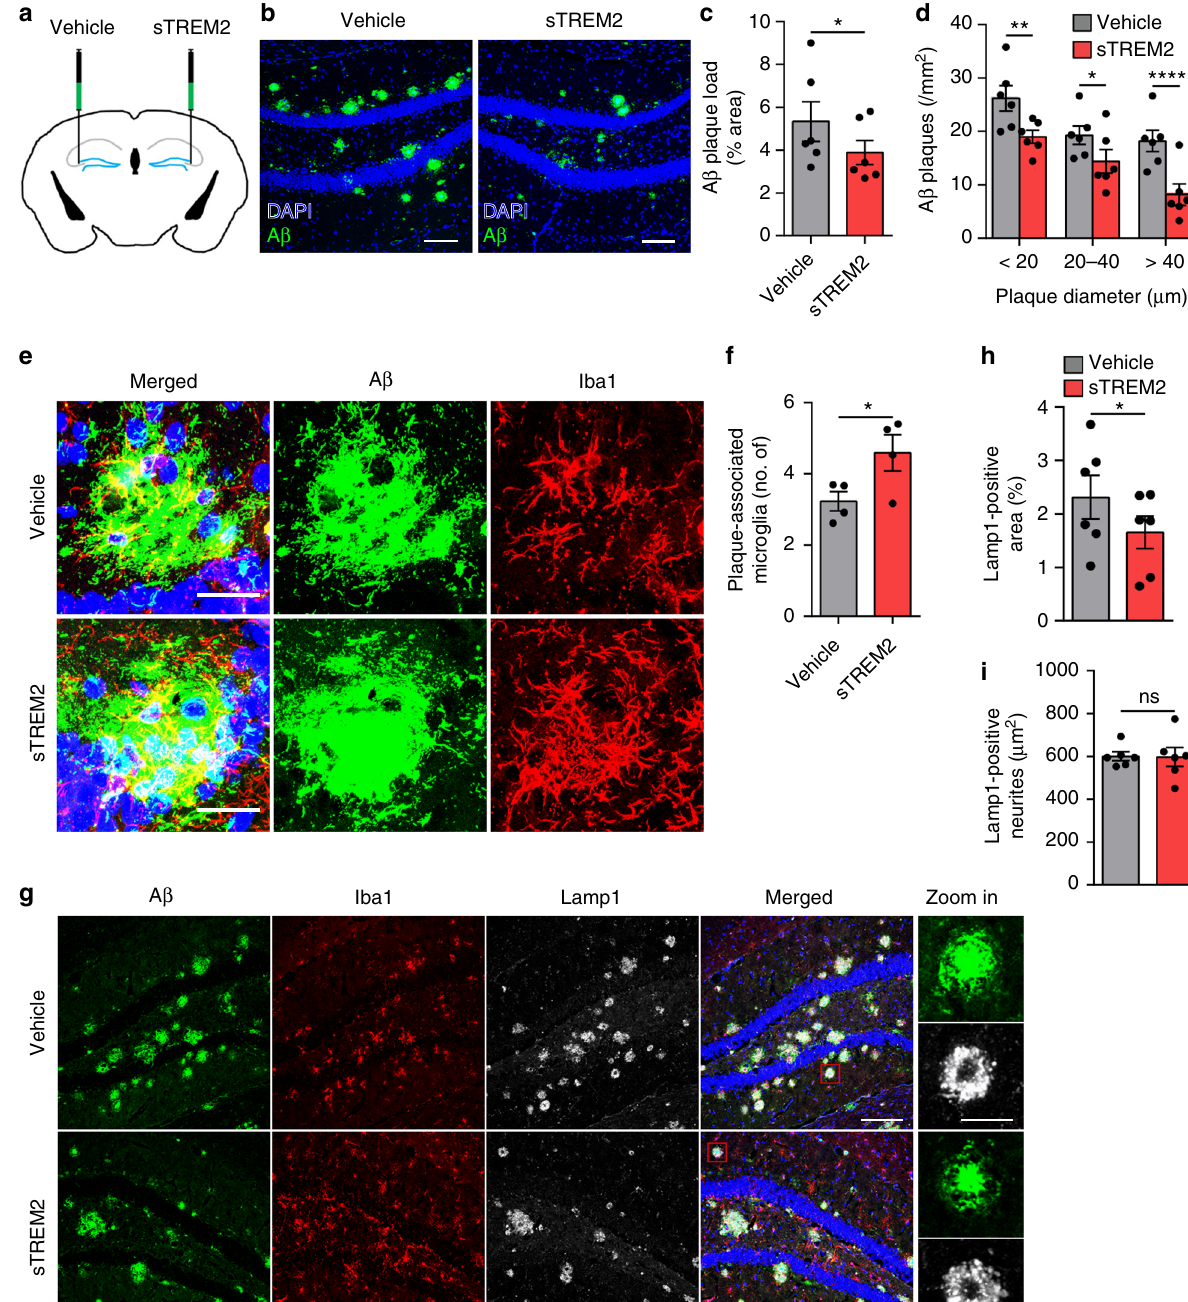
Fig. 2a), consistent with our previous report that sTREM2 promotes microglial activation 43 . Importantly, both the pro-in fl ammatory cytokine IL-1 β and the immune-activating molecule lipopoly- saccharide enhanced the production of sTREM2 in primary microglia, as measured by enzyme-linked immunosorbent assay (ELISA); while the anti-in fl ammatory cytokine IL-10 had a minimal effect (Supplementary Fig. 2b). Therefore, sTREM2 and the pro- in fl ammatory cytokines appear to form a positive feedback loop, resulting in sustained microglial